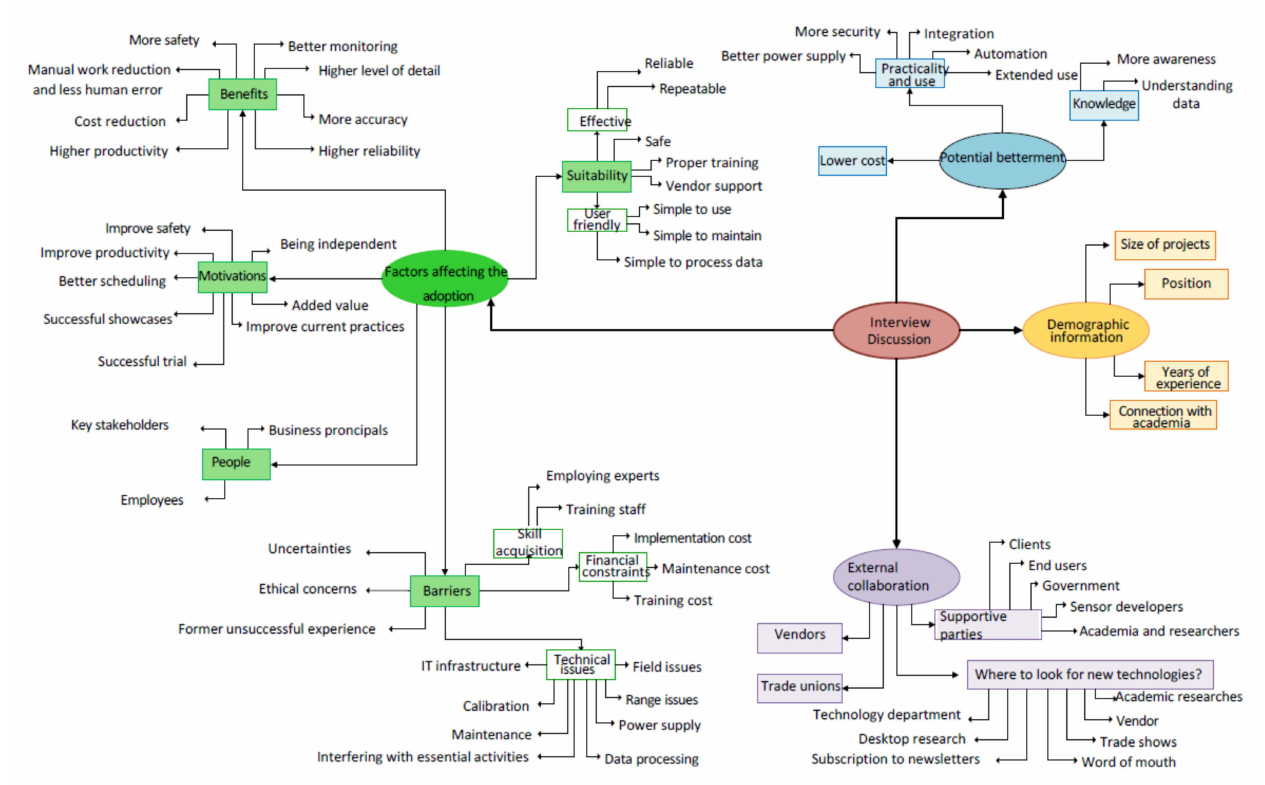
Figure 5. Code of interview